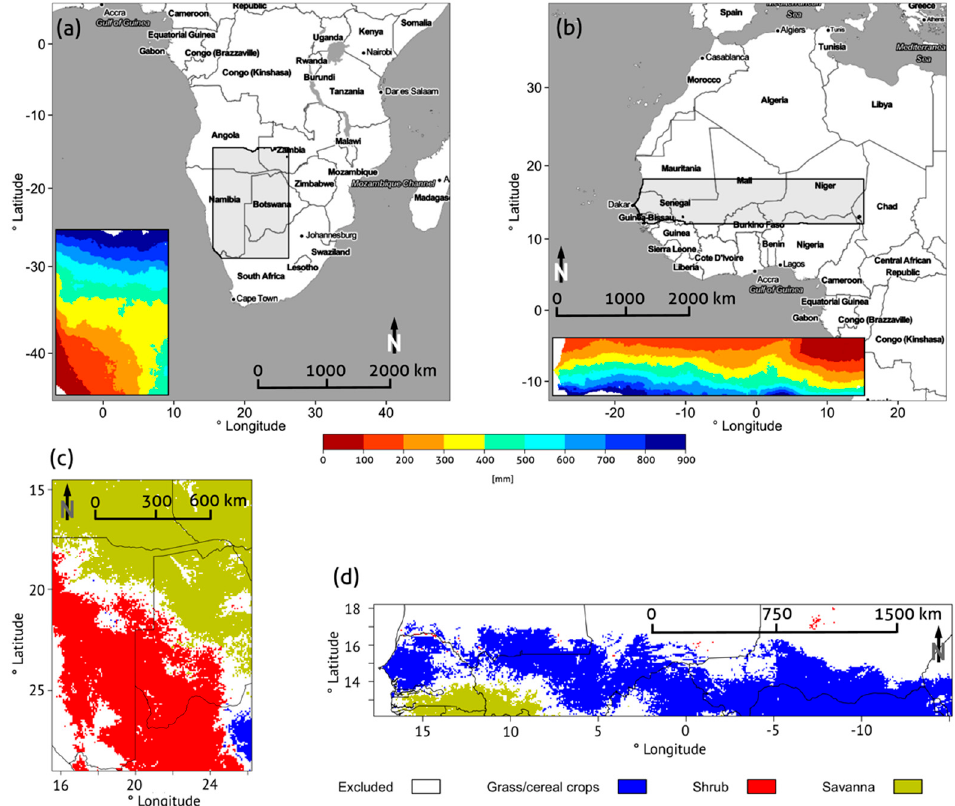
Figure 1. Overview of the two study regions, ( a ) South West Africa (SWA) and ( b ) West Africa (WA). Insets are enlarged maps of the respective gradients of mean annual precipitation (MAP) derived from African Rainfall Climatology 2 (ARC2) data. White areas on the rainfall maps indicate areas, which were not considered as they were either masked as water bodies or had MAP values > 900 mm.